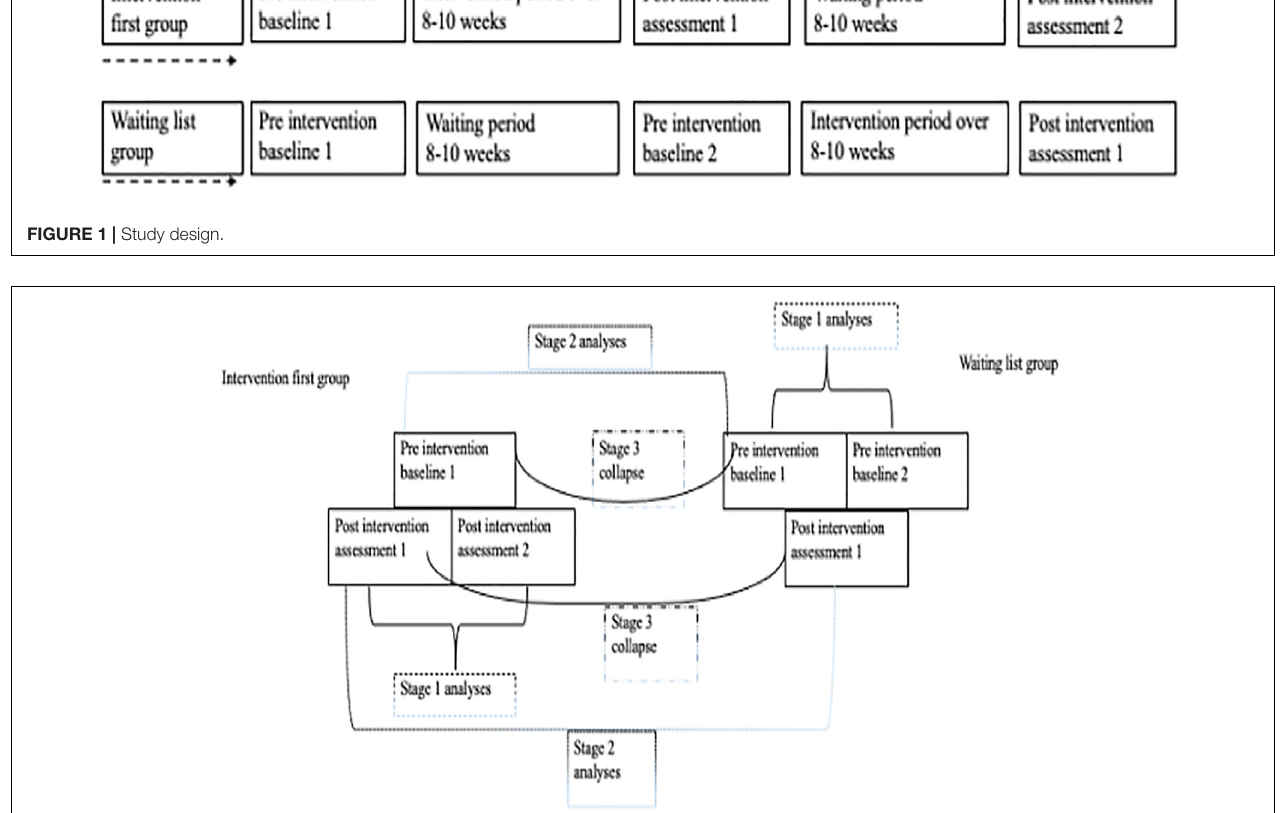
FIGURE 2 | Illustration of the stage-by-stage process leading to the collapsing of the